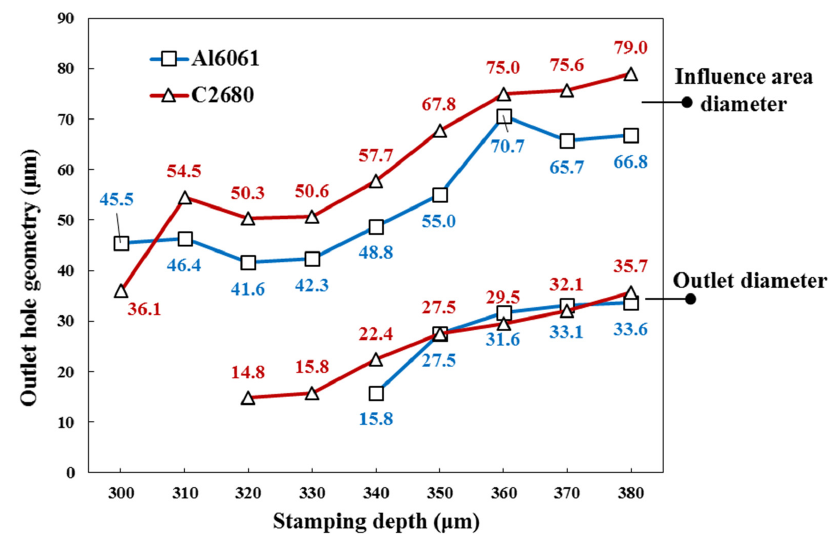
Figure 12. Stamping depth/outlet hole geometry analysis.